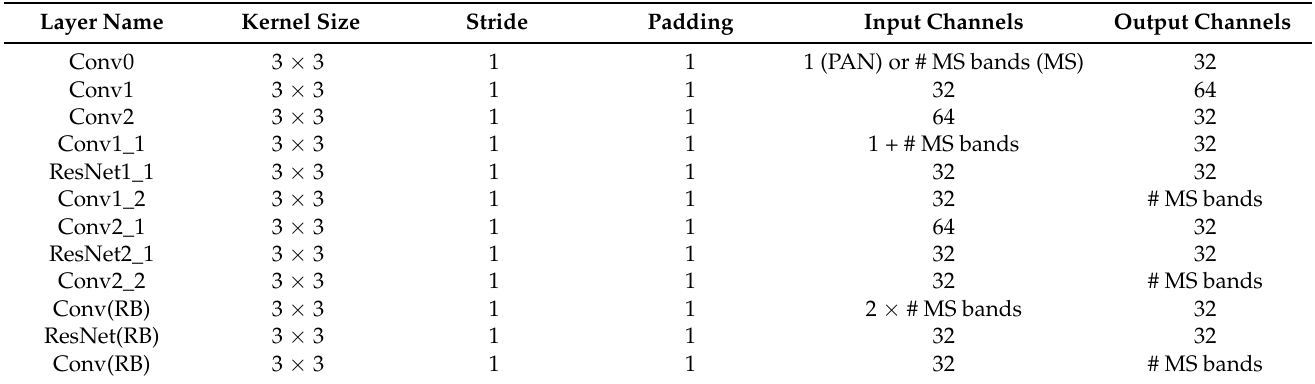
Table 1. Parameters of each convolutional layer in the MSB block and RB